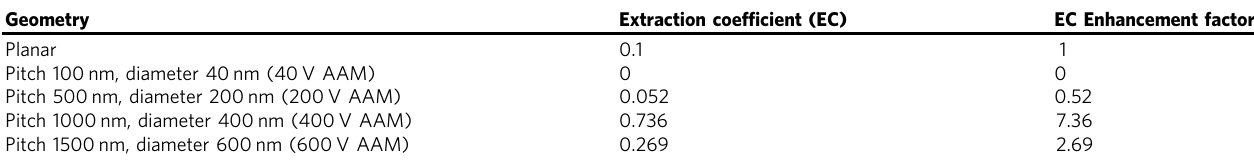
Table 2 Simulation result of the light extraction coef fi cient (EC) and its enhancement compared with the planar counterpart for different pitches with aspect ratio of 0.4